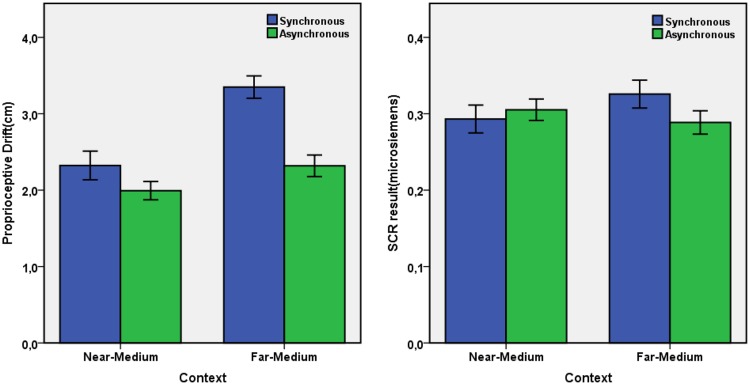
Proprioceptive Drift (left) and SCR (right) results, the error bars represent ±1 SE.